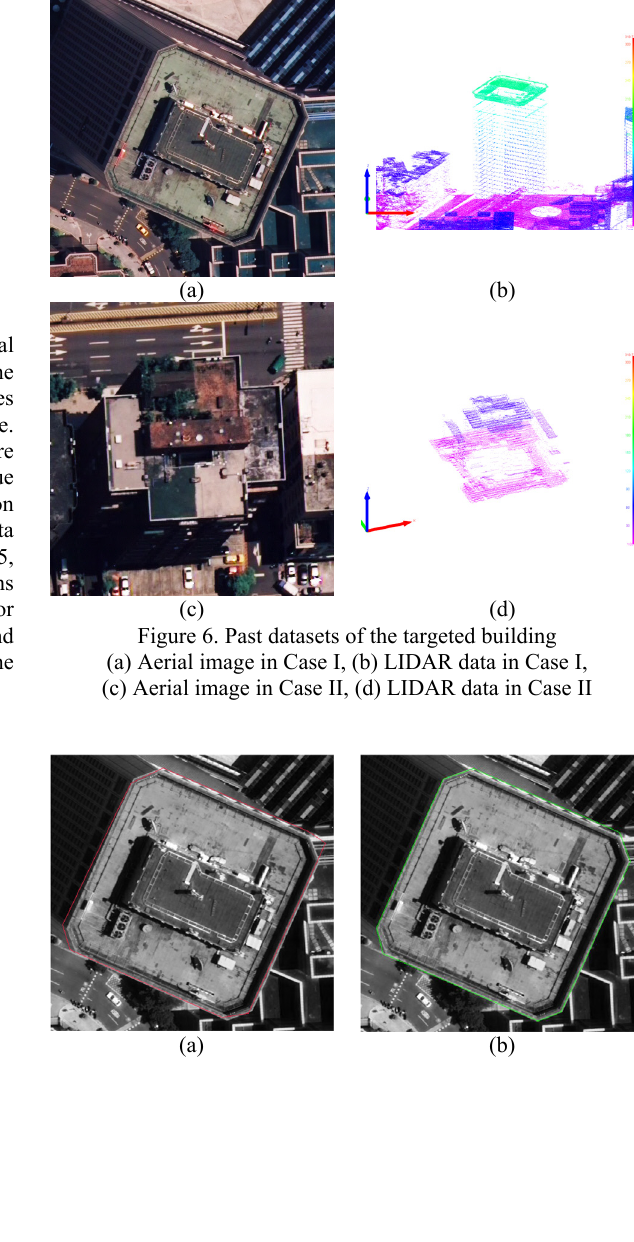
Figure 5. The difference of parametric patterns